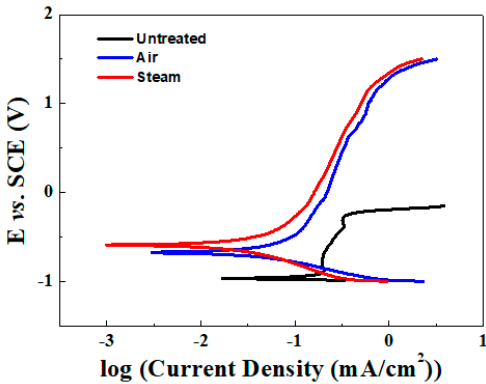
Figure 8. Potentiodynamic polarization curves of the three different specimens.